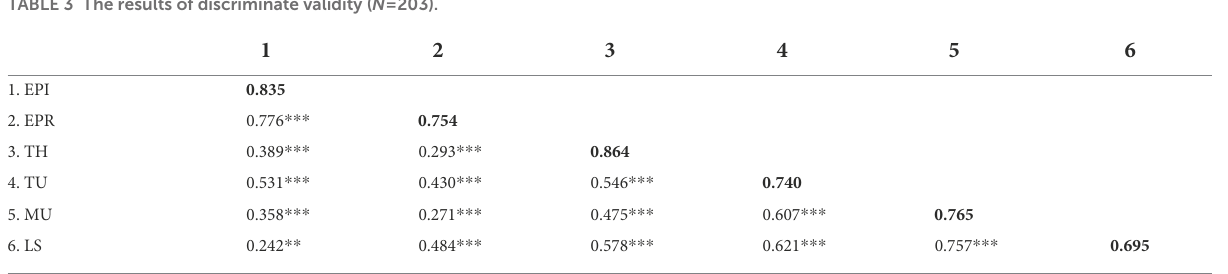
Diagonal elements are the square roots of the AVE; The elements that appeared in lower left–left are the Pearson correlation coefficient between constructs; EPI, exploitative improvisation; EPR, explorative improvisation; TU, technology uncertainty; MU, market uncertainty; TH, entrepreneurial team heterogeneity; LS, lean search. Significance levels are given below. ** p < 0.01; *** p <